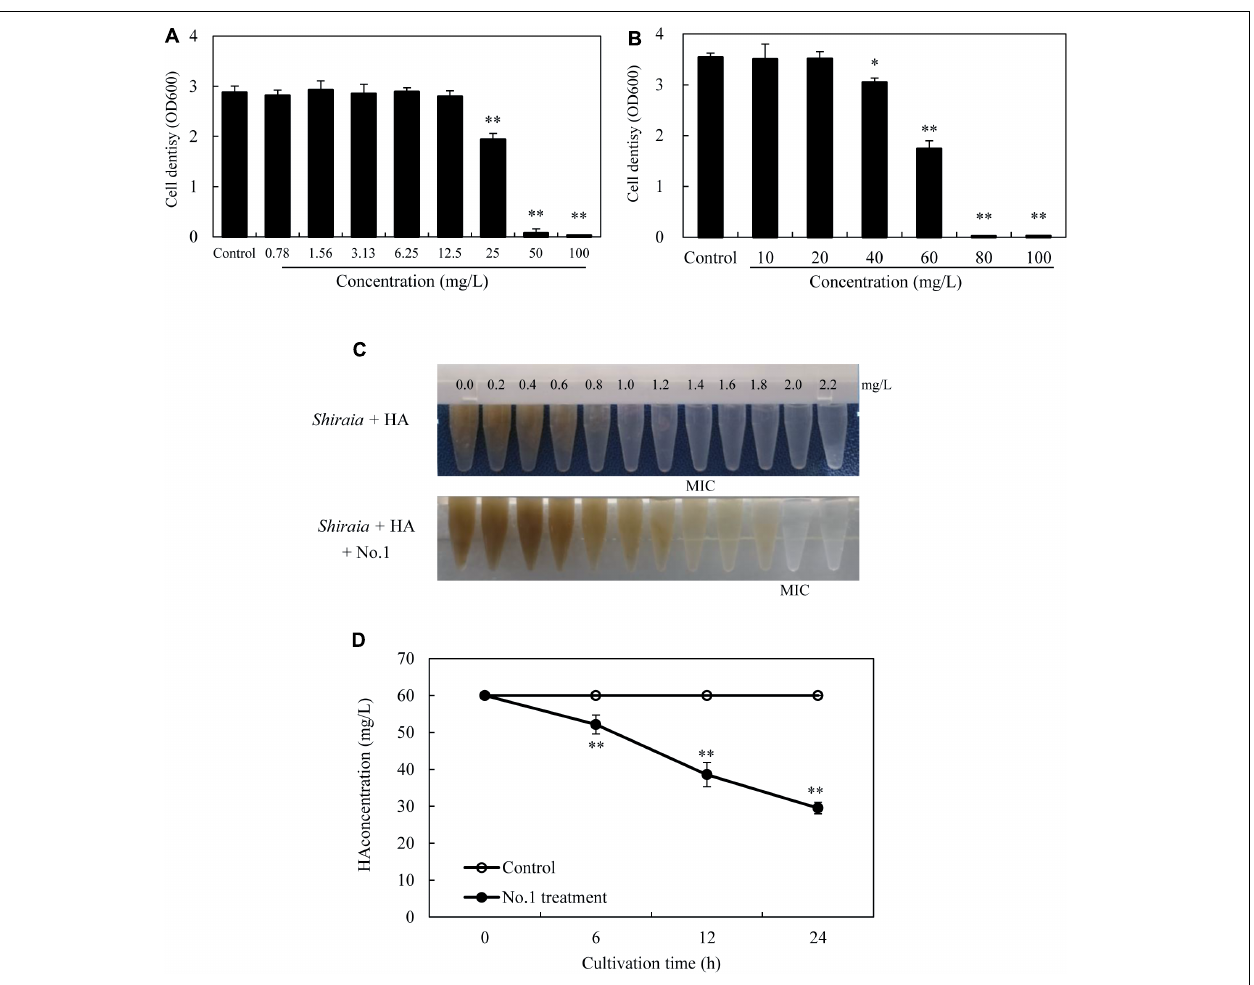
FIGURE 11 | The bacterial susceptibilities to HA. P. fulva SB1 (A) or B. cereus No. 1 (B) was incubated in LB with HA at 0–100 mg/L on a rotary shaker at 150 rpm and 28 ◦ C for 24 h in the dark. (C) The toxicity of HA on the fungal growth of Shiraia sp. S9. HA at different concentrations (0.0–2.2 mg/L) was added to the fungal spore suspension (800 µ l of 1 × 10 5 spores/ml) with or without addition of No. 1 cells for 8 days. (D) Time profiles of HA degradation in LB with No. 1 cells. The bacterial cells (0.75 × 10 3 cells/ml, 400 µ l) mixed with 60 mg/L HA were incubated in the dark on a rotary shaker at 150 rpm and 28 ◦ C. MIC, minimum inhibitory concentration. Values are mean ± SD from three independent experiments. ∗ p < 0.05, ∗∗ p < 0.01 versus control